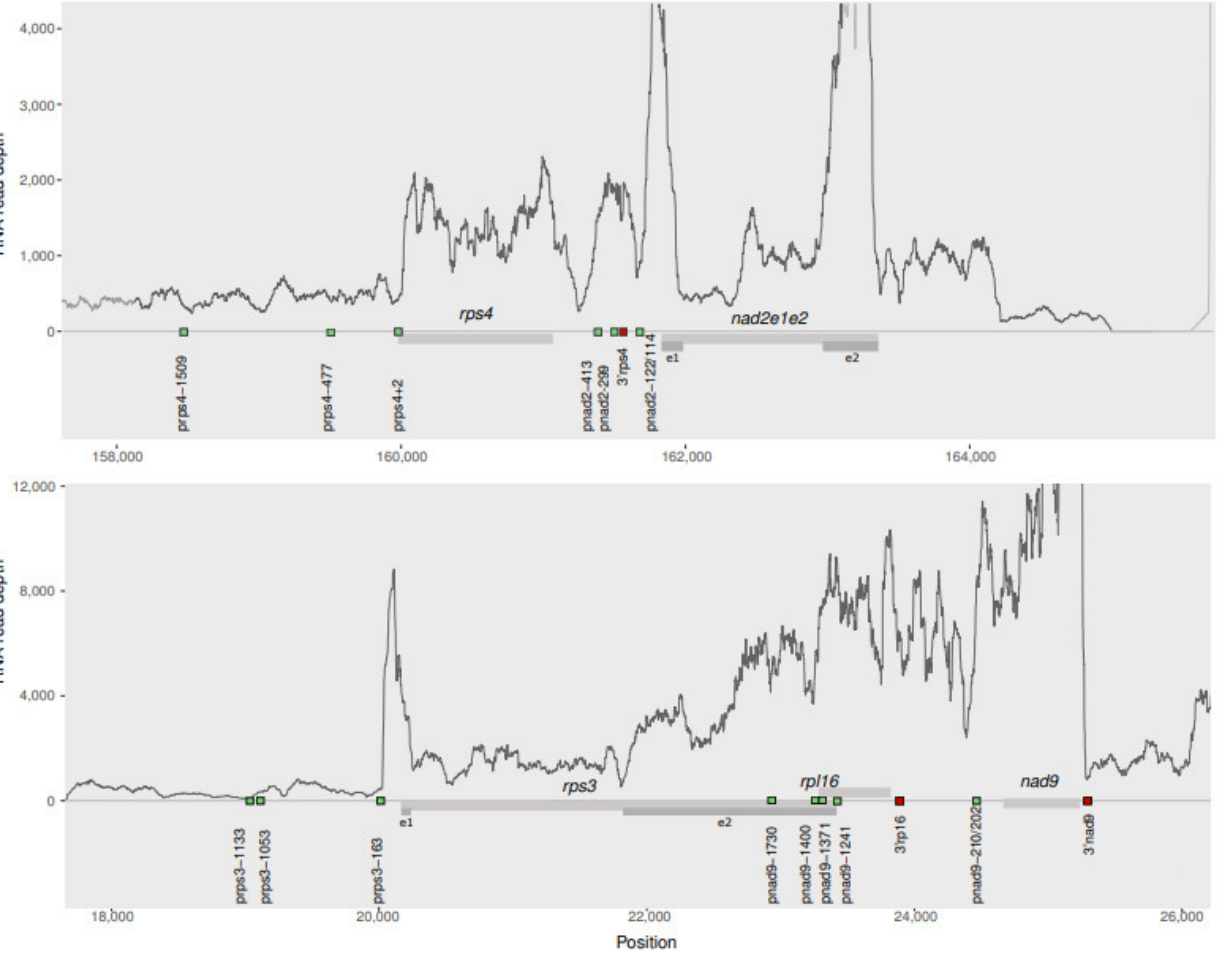
Figure 3. RNA read depth of protein-coding genes located at a distance < 2 kb in the Arabidopsis mitochondria based on the combined data sets of the three biological samples. A drop in the read depth between the genes rps4 and nad2e1e2 suggests independent transcription. A continuously elevated read depth across rps3 , rpl16 and nad9 suggests that these genes are co-transcribed. Gray bars represent genes and dark gray bars are exons. Green and red squares represent start of transcription and 3′ termini, respectively, identified experimentally [36,42,44]. Below each graph, the mtDNA coordi- nates of the strand in which the genes are located are shown.